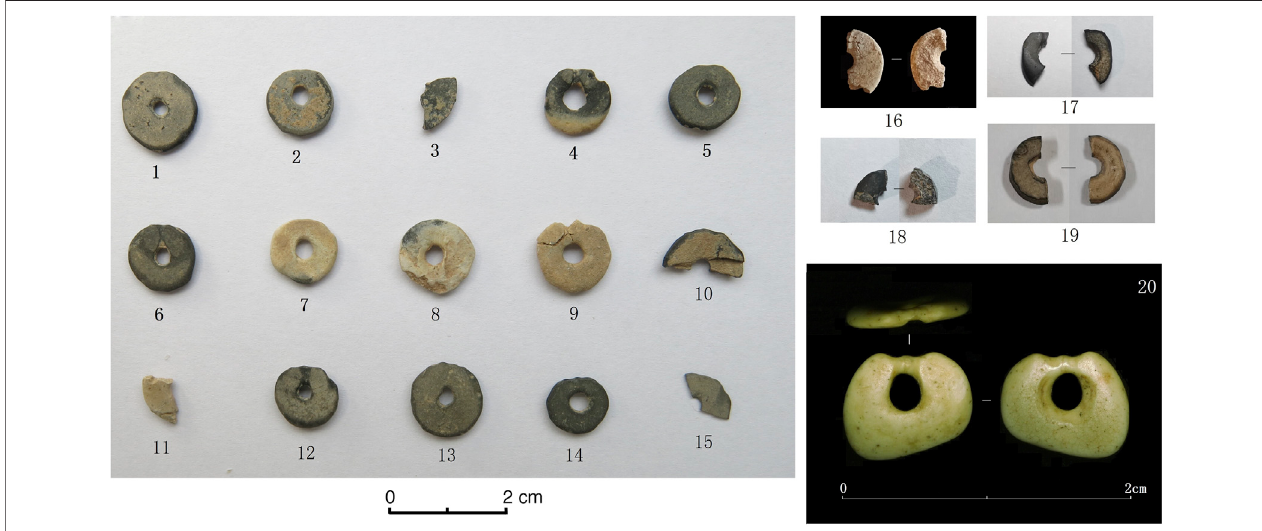
FIGURE 3 | Perforated OES pendants and pendant fragments from Shizitan SZT29 Layer 7 Spits 5-2 and SZT24. 1 – 19 are to the same 2 cm scale. 1 – 15. PendantswithusewearfromSZT29Layer7Spits5 – 2,exteriorsurfaces;16 – 19.Exteriorsurface (left) andinteriorsurface (right) ofpendantswithusewearfromSZT29 Layer 7 Spits 5-2; 20. SZT24, pendant top, exterior, and interior, showing heavy usewear. Scales are 2 cm in length.